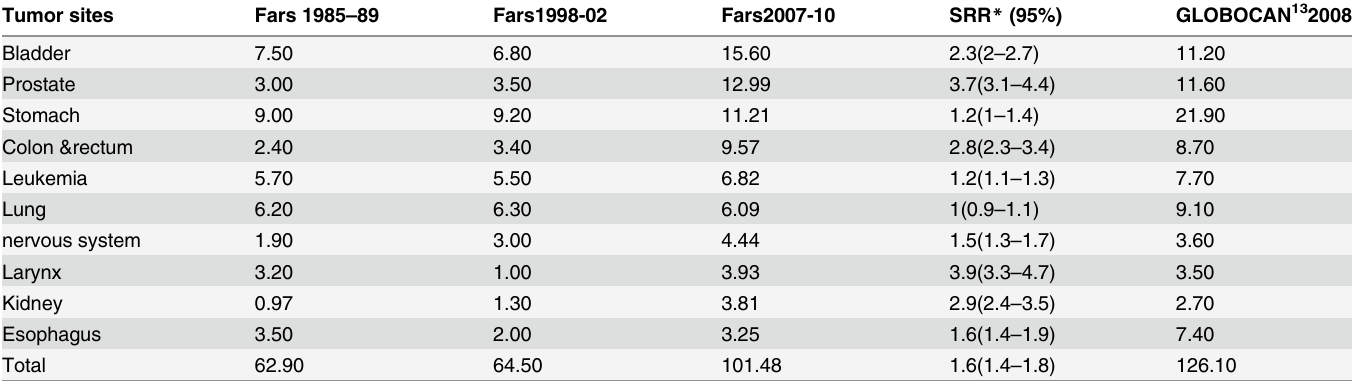
Table 3. Top ten cancers in men based on age-standardized rates per 100,000 person-years (ASR) and standardized rate ratio (SRR) in Fars prov- ince comparing to previous studies in Fars, GLOBOCAN 2008. Tumor